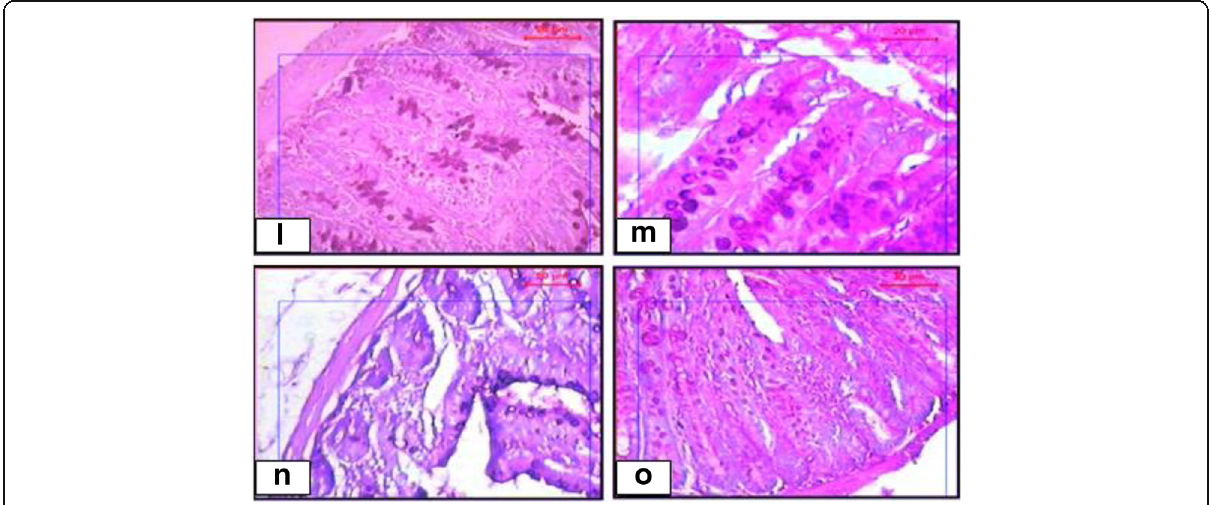
Fig. 5 Photomicrographs of jejunal sections showing distribution of mucopolysaccharides in the jejunal mucosa of the control and treated groups (PAS). l , m Jejunal section of control and GABA-treated rats showing normal number and distribution of goblet cells with normal mucin content (×100, ×200). n Jejunal section of IR group showing marked decrease in number of goblet cells with depletion of mucin throughout the jejunal mucosa (×100). o Jejunal section of IR + GABA group showing nearly normal number of goblet cells with normal mucin content